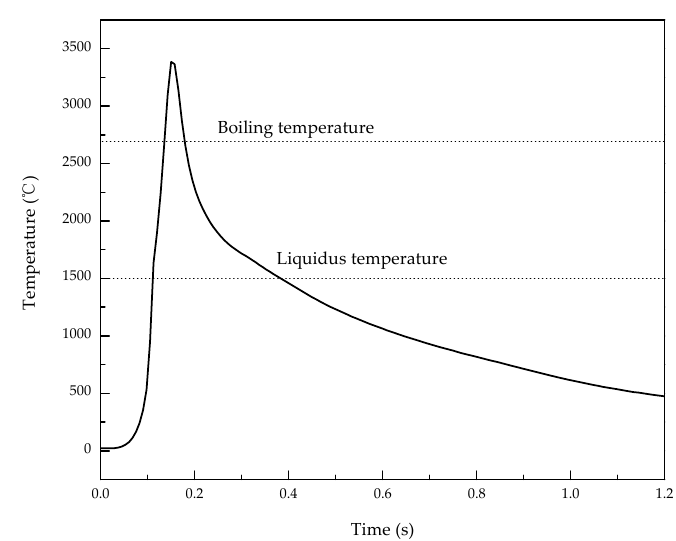
Figure 17. Calculated thermal cycle of a point in the tailored line between thick plate and thin plate.